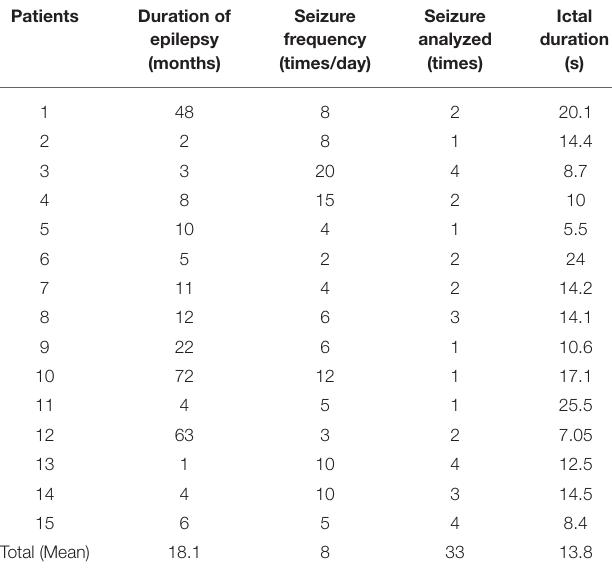
TABLE 1 | Clinical characteristics of CAE